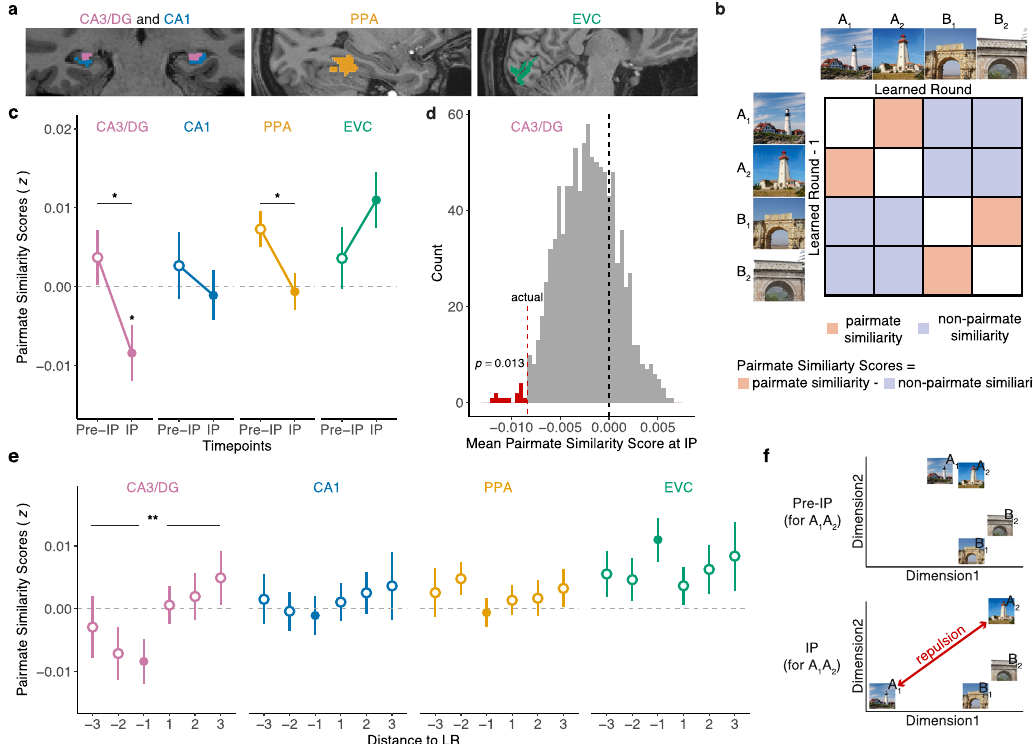
Fig. 2 Pairmate similarity scores change at the behavioral in fl ection point. a Regions of interest included CA3/dentate gyrus (CA3/DG, pink) and CA1 (blue) in the hippocampus, the parahippocampal place area (PPA, yellow), and early visual cortex (EVC, green). b Correlation matrix illustrating how pairmate similarity scores were computed at the behavioral in fl ection point. See Methods for details. c Pairmate similarity scores at the behavioral in fl ection point (IP) and just prior to the in fl ection point (pre-IP) across different regions of interest (ROIs). Pairmate similarity scores signi fi cantly varied by ROI ( p = 0.009, repeated measures ANOVA) and there was a signi fi cant interaction between ROIs and behavioral state ( p = 0.037, repeated measures ANOVA). In CA3/DG, pairmate similarity scores at the IP were signi fi cantly lower than 0 ( p = 0.025, two-tailed one-sample t -test) and signi fi cantly lower than the pre-IP state ( p = 0.033, two-tailed paired samples t -test). In PPA, pairmate similarity scores decreased from pre-IP to IP ( p = 0.030, two-tailed paired samples t -test). d A permutation test (1000 iterations) was performed by shuf fl ing, within participants, the mapping between the behavioral in fl ection point and scene pairmates. In CA3/dentate gyrus the actual mean group-level pairmate similarity score at the IP was lower than 98.70% of the permuted mean similarity scores ( p = 0.013, one-tailed permutation test). e Pairmate similarity scores calculated by correlating the learned round (LR) with each of the three preceding rounds ( – distance to LR) and each of the three succeeding rounds ( + distance to LR). [Note: the in fl ection point was de fi ned as the correlation between the LR and the immediately preceding round (LR − 1); the in fl ection points are depicted by fi lled circles and are